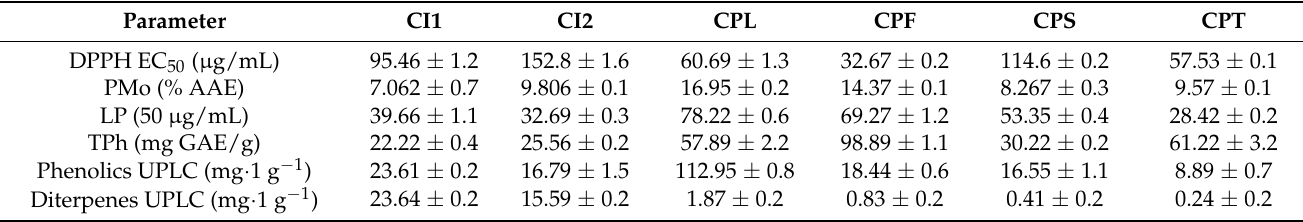
Table 5. Comparisons of feed intake and total track digestibility of lambs fed with Coleus amboinicus Lour. ( n = 3, mean value).